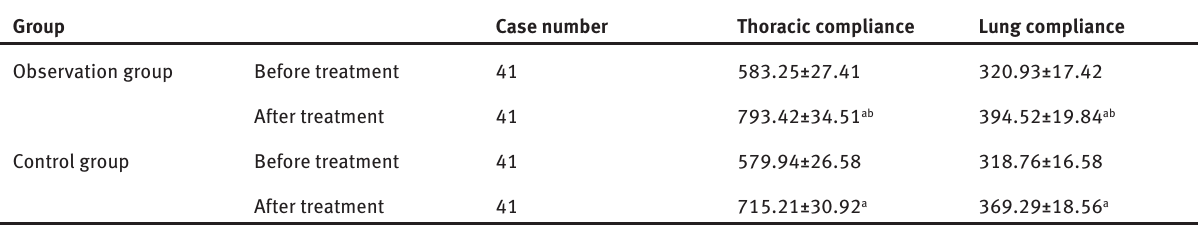
Table 6: Comparison of thoracic and lung compliance between two groups before and after treatment ( ±s)